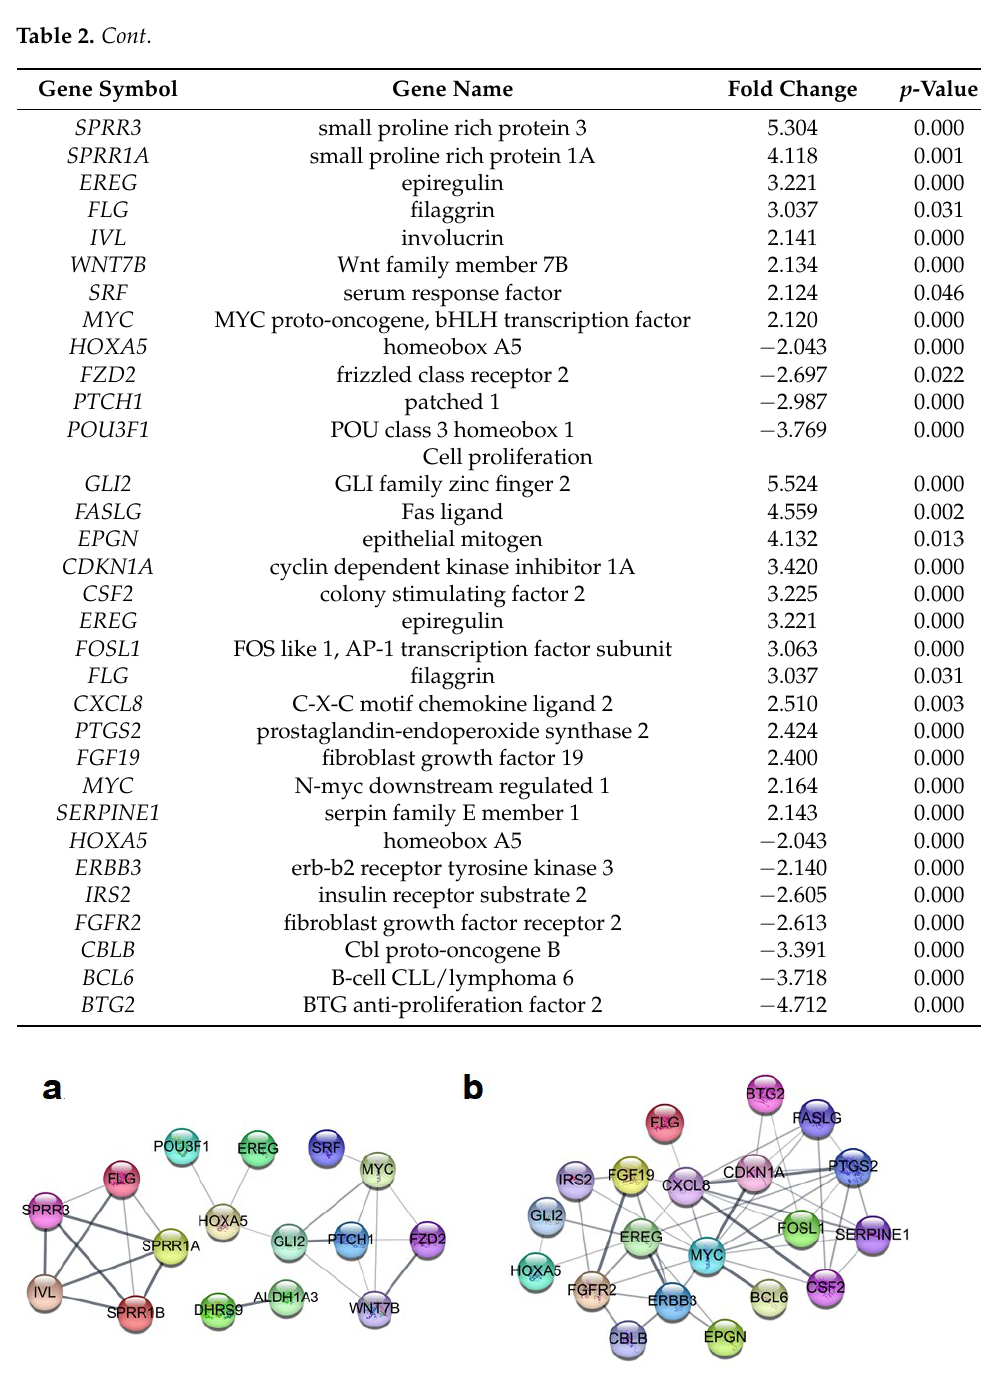
Figure 5. Networks of gene–gene interactions involved in epithelial cell differentiation and development ( a ) and cell proliferation ( b ). These networks were visualized with a search tool for the retrieval of interacting genes (STRING) and constructed with a required confidence score of 0.4. Nodes and lines represent genes and interactions between genes, respectively.